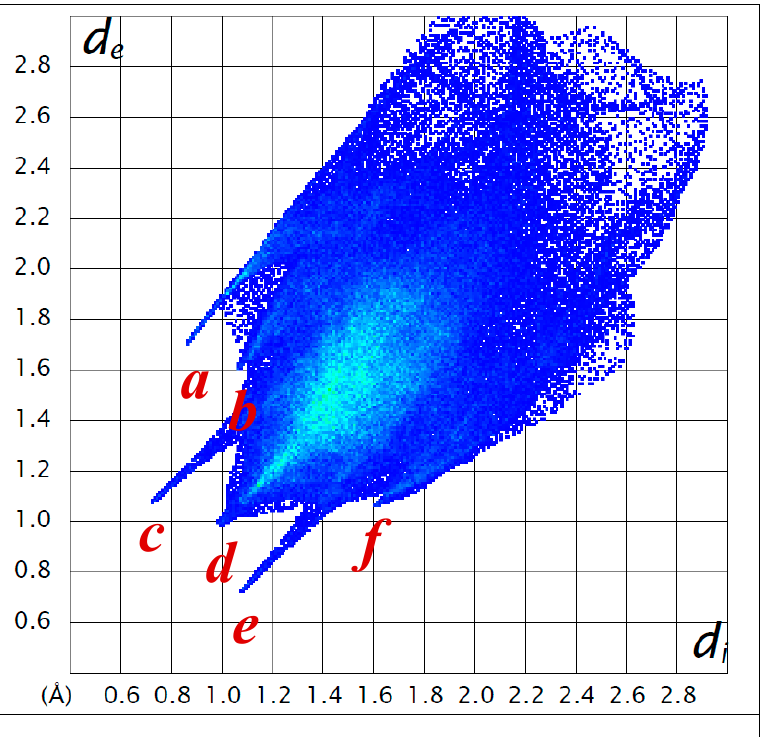
Figure 5. Two-dimensional Hirshfeld fingerprint plots. The wings correspond to the following interactions present in 1 : a : H(O7) … I; b and f : H … H with hydrogen atoms corresponding to C19 (methyl group) and C36 (aromatic ring); c : H(O12) … O26; d : H … H interactions with the hydrogen atoms bonded to C6 and to carbon atoms of the alkyl ammonium residue; e : O26 … H-O12. d e and d i are given in Å.